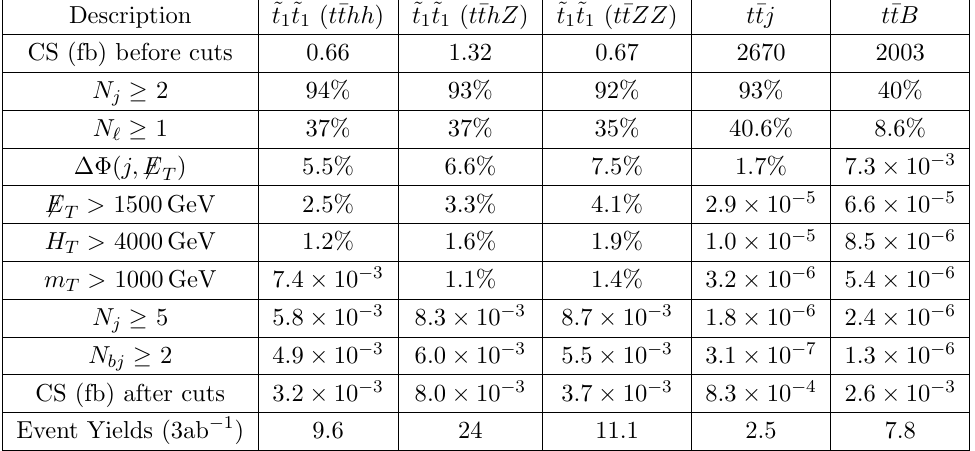
Table 8 . The cumulative cut e(cid:14)ciencies, cross sections and yields for the signal with m ~ 4000 GeV and m = 1000 GeV as well as SM backgrounds for 100 TeV pp collider with 3 ab (cid:0) 1 (cid:31) 0 1 integrated luminosity. The B stands for bosons including W , Z and h